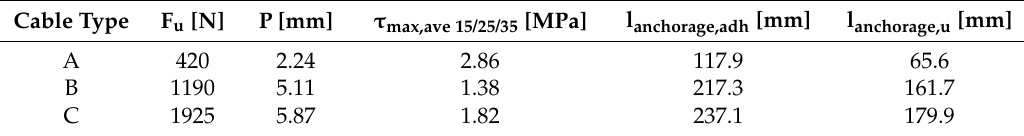
Table 4. Basic anchorage lengths for applied cables in printed concrete, based on adhesive (l anchorage,adh ) and ultimate (l anchorage,u ) bond stress.